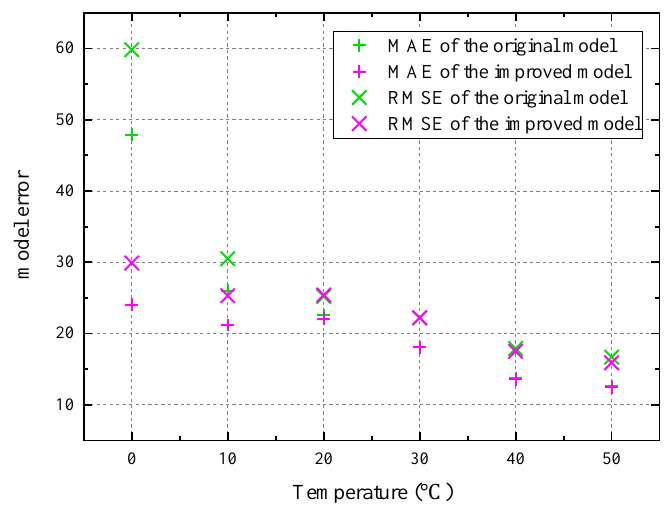
Figure 8. Comparison between measured data and model results at 0 °C: ( a ) voltage of experimental, original model and improved model; ( b ) estimated error of the original and improved model.